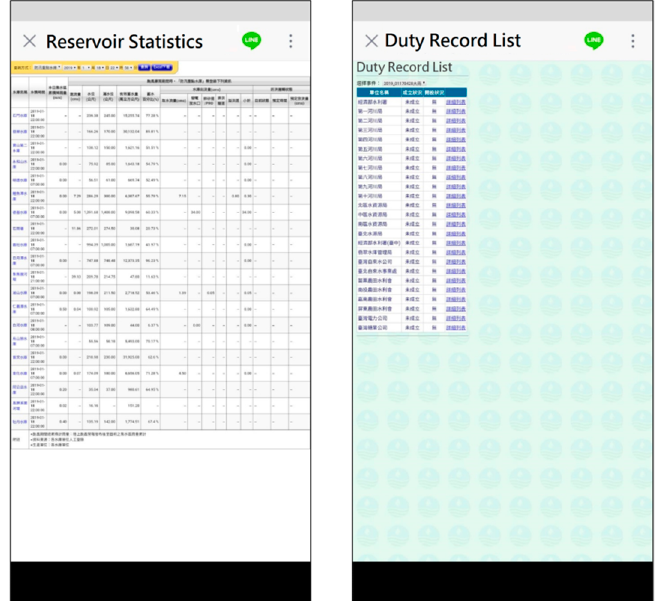
Figure 8. Examples of inappropriate data revealing approaches.